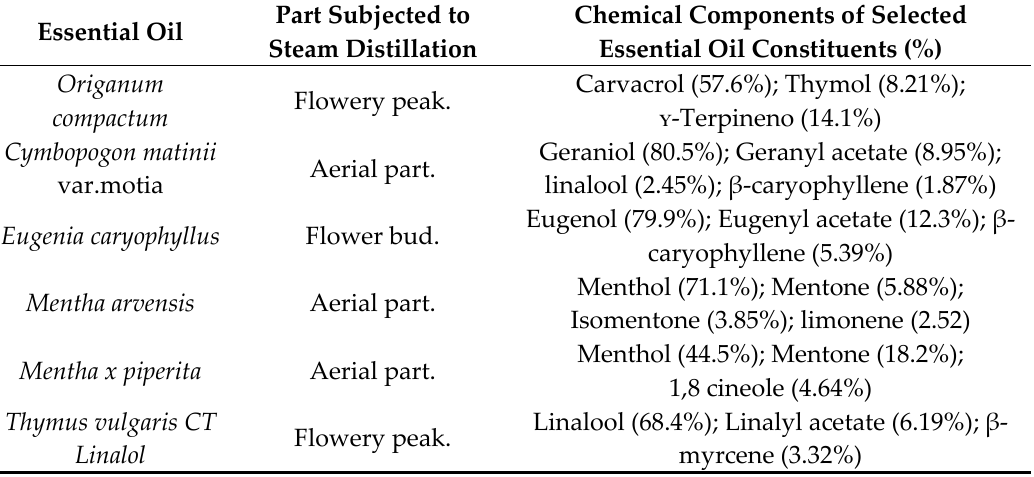
Table A1. Chemical components from the essential oils. The table shows the essential oils analyzed: part of the plant and a percentage of some chemical components of selected essential oil after was subjected to steam distillation (data obtained from analysis sheet of